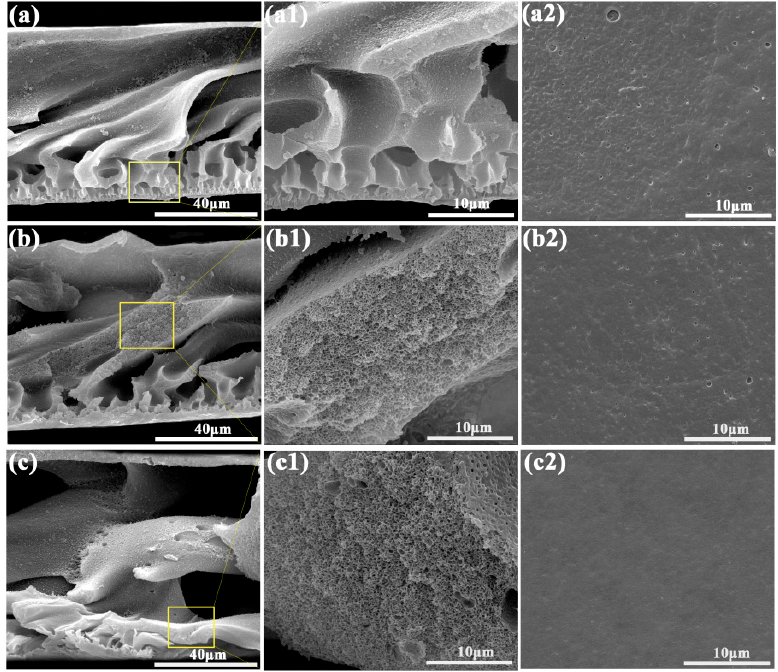
Figure 2. Cross-section SEM images of SPEN-CTAB-0% ( a ), ( a1 ); SPEN-CTAB-5% ( b ), ( b1 ); SPEN-CTAB-15% ( c ), ( c1 ). Surface SEM images of SPEN-CTAB-0% ( a2 ), SPEN-CTAB-5% ( b2 ) and SPEN-CTAB-15% ( c2 ). CTAB: cetyltrimethyl ammonium bromide.